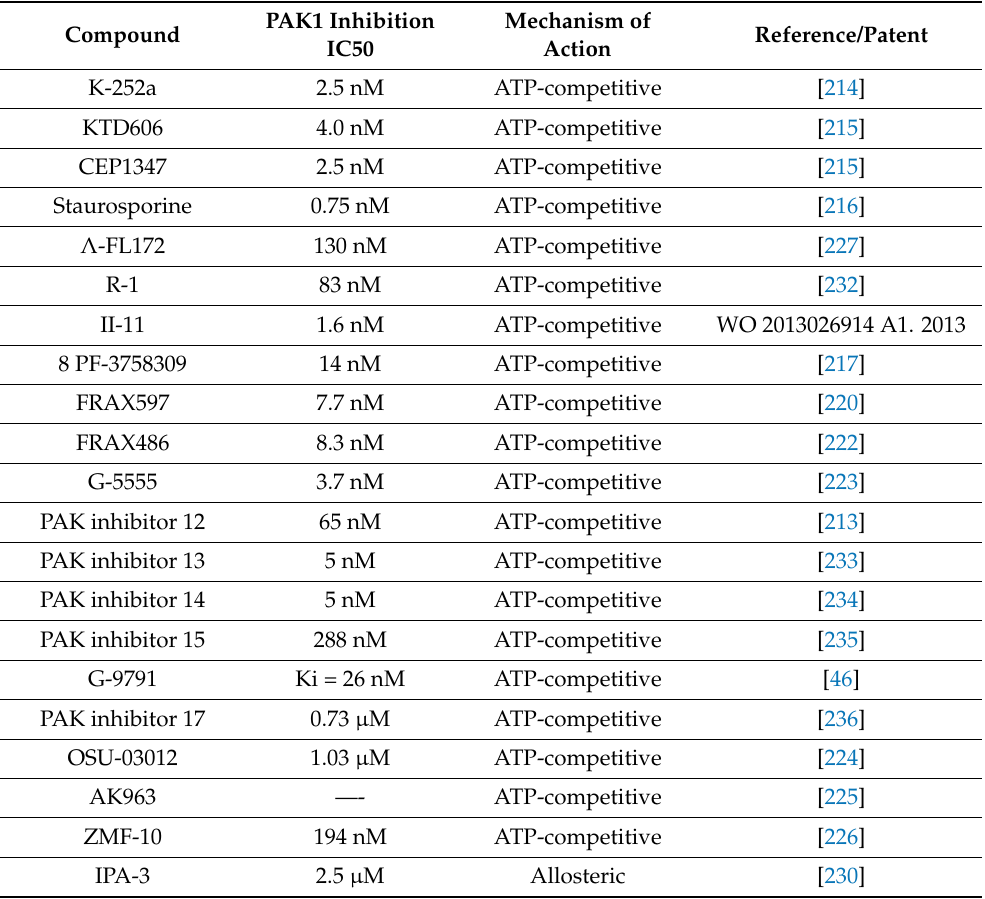
Table 2. ATP-competitive and allosteric inhibitors of PAK1. PAK1 Inhibition Compound